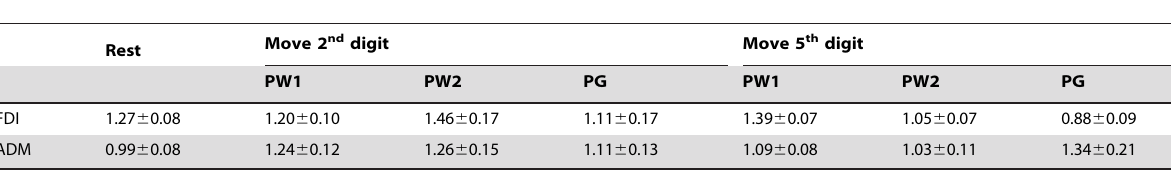
Table 2. Unconditioned MEP size for FDI and ADM during all conditions.